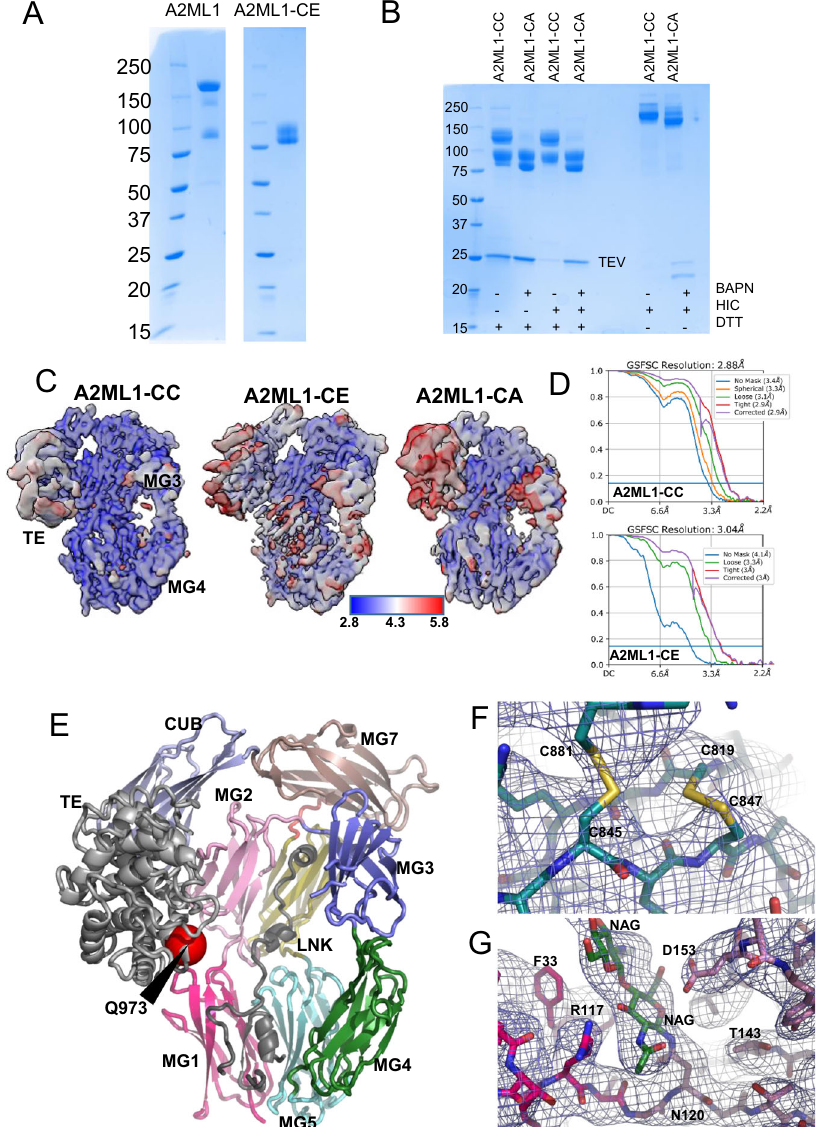
Fig. 3 The structures of TEV-P-cleaved A2ML1. A SDS-PAGE analysis of A2ML1 and empty trap TEV-P cleaved A2ML1-CE and B A2ML1-CC and -CA samples (to the right, the samples are shown after hydrophobic interaction chromatography (HIC) which showed co-elution of TEV-P with A2ML1 even without covalent protease trapping in the A2ML1-CA sample). The A2ML1-CE sample and post-HIC A2ML1-CC and -CA samples that are shown here were used for preparation of grids for cryo-EM; these samples were prepared once. Molecular weight markers on shown on the left-hand side of each gel in kDa. C Local resolution maps for the three different monomeric TEV-P cleaved A2ML1. Notice the signi fi cantly lower resolution for the TE and MG3 domains compared to the rest of the molecule. D Fourier shell correlation plots suggest resolution of 2.9 Å and 3.0 Å for A2ML1-CC and A2ML1-CE, respectively. E TEV-P conjugated A2ML1-CC in a cartoon representation with the domains colored as in Fig. 2A. The orientation is similar to that in panel C. The location of thioester glutamine is indicated as a red sphere marked Q973. For comparison, native A2ML1 is presented with the same orientation of the MG-ring in the right part of Fig. 2G. F EM map of the MG7 domain in A2ML1-CC con fi rming two disul fi des bridges formed by four cysteines that are located close to each other. G EM map for two NAG residues linked to Asn120 in the linker connecting the MG1 and MG2 domains in